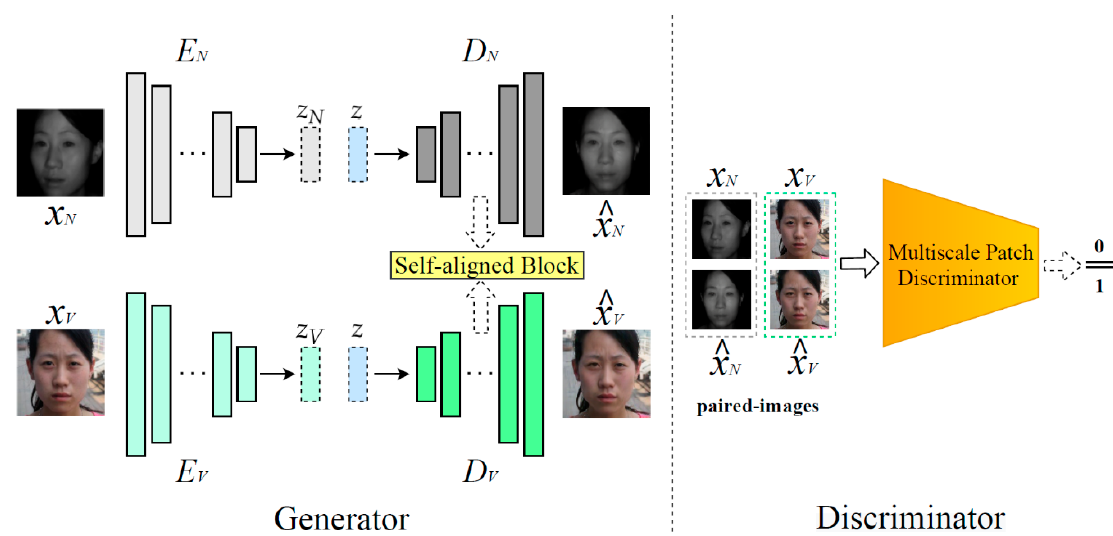
Figure 2. The training process of our proposed self-aligned generation architecture. Given the paired data from the training dataset, we first reverse them by E N , D N , E V and D V , respectively (the left part). Then, we use a multiscale patch discriminator (the right part) to do the adversarial learning with the generator. The solid-lined rectangle stands for the residual block, and the dotted-lined rectangle stands for the latent code z .